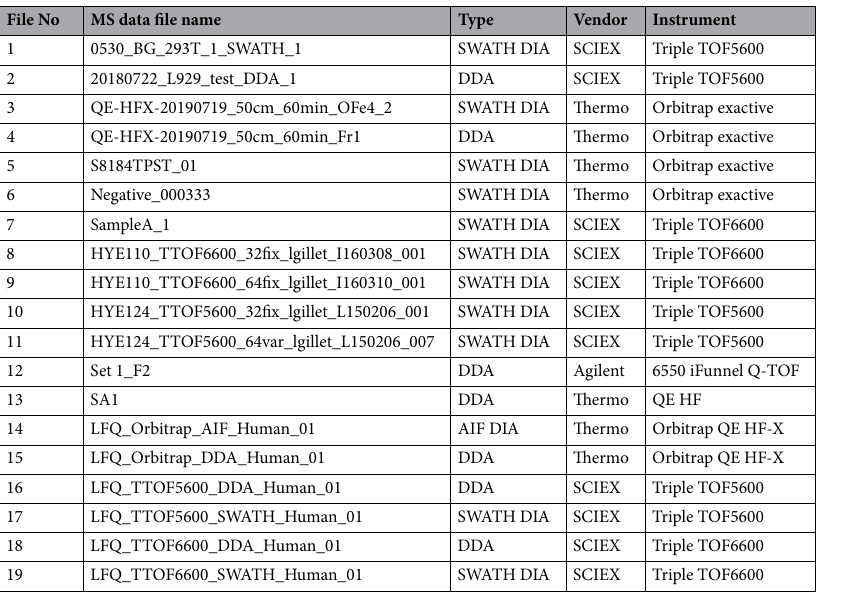
Table 1. The raw MS data files used in validation, together with MS instrument and method information. Files 1–2 are from ref 17 , data files 3–4 are from ref 18 , 5 is from ref 19 , 6 is from ref 20 , 7 and 13 is from ref 21 , 8–11 are from ref 22 , 12 is from ref 23 , and finally 14–19 are from ref 24